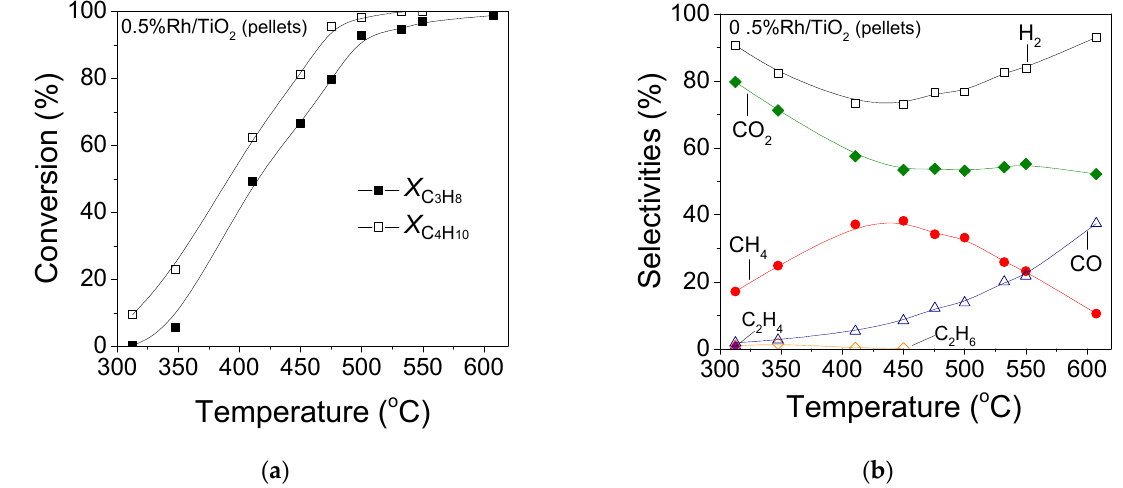
Figure 12. Catalytic performance of 0.5%Rh/TiO 2 catalyst in the form of pellets for the propane/butane steam-reforming reaction under realistic reaction conditions. ( a ) Conversions of C 3 H 8 and C 4 H 10 ; ( b ) Selectivities toward reaction products. Experimental conditions: H 2 O/C = 3.25; GHSV= 9000 h − 1 ; Feed composition: 4.27% C 3 Η 8 , 0.23% C 4 Η 10 , 0.15% Ar, 44% H 2 O.